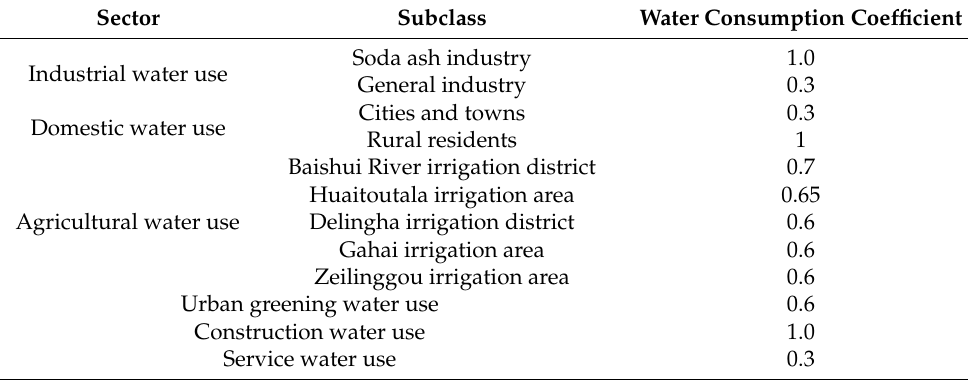
Table 1. Water consumption coefficient for different sectors.